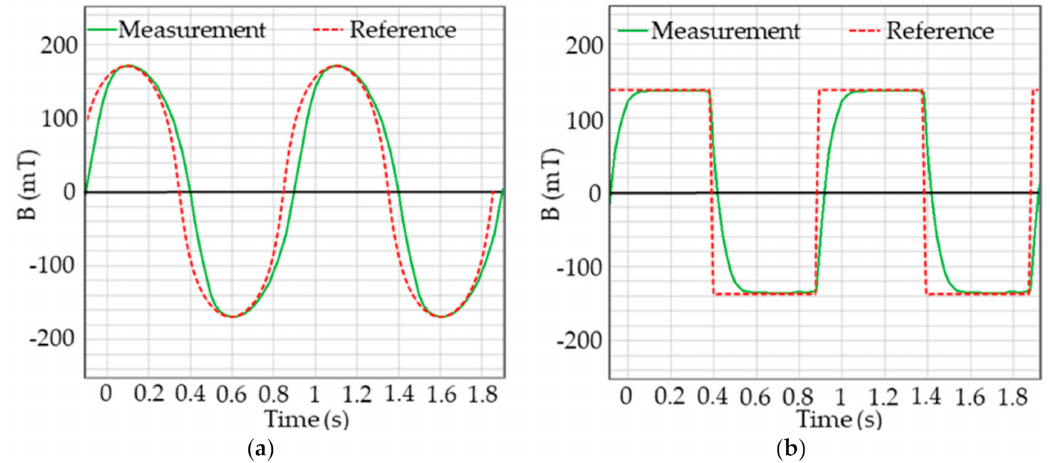
Figure 8. The change curve of magnetic flux density with time. ( a ) Sin-AC; ( b )